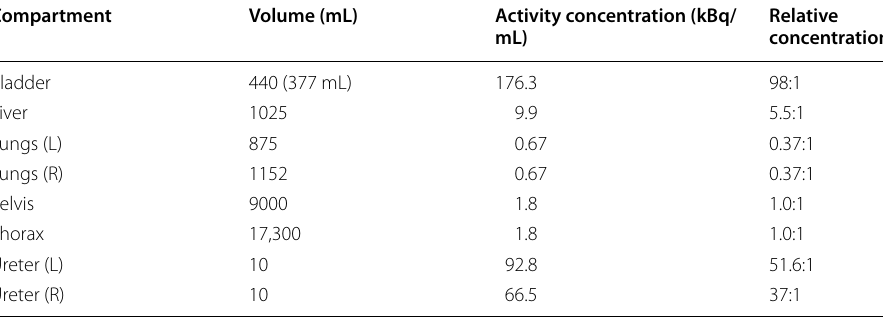
Table 1 Target activity concentrations for compartments in the Probe-IQ phantom